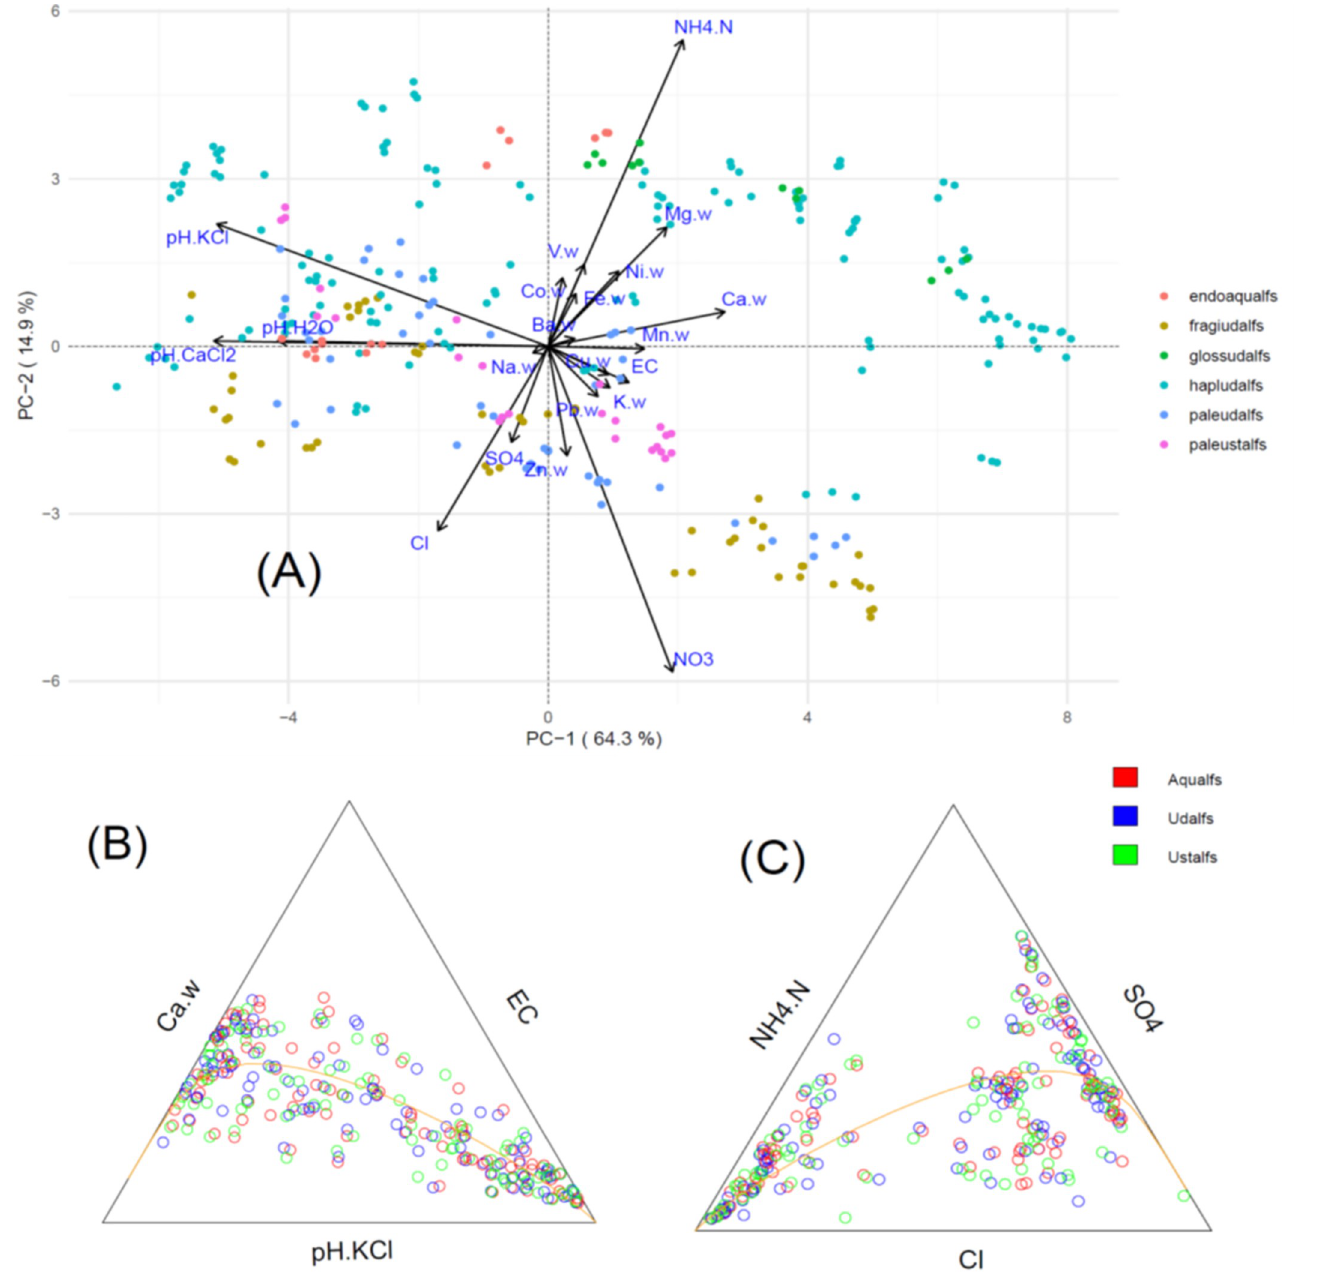
Fig 2. Statistical plots for the water-extracted (WE) composition (suffix “.w” refers to a constituent from the WE composition). (A) Clr-transformed biplots for the full composition with samples grouped based on the Great Group designation. (B) ternary principal component (t-PCA) plot for the pH.KCl-Ca-EC subcomposition, with samples grouped based on the Suborder designation. (C) t-PCA plot for the NH 4 .N-Cl-SO 4 subcompositions, grouped based on the Suborder